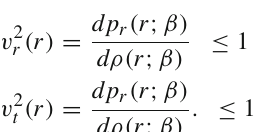
Fig. 5 Behaviour of radial velocity ( v 2 r ) and tangential velocity ( v 2 t ) vs. radial coordinate r / R with different values of n for LMC X − 4 be defined